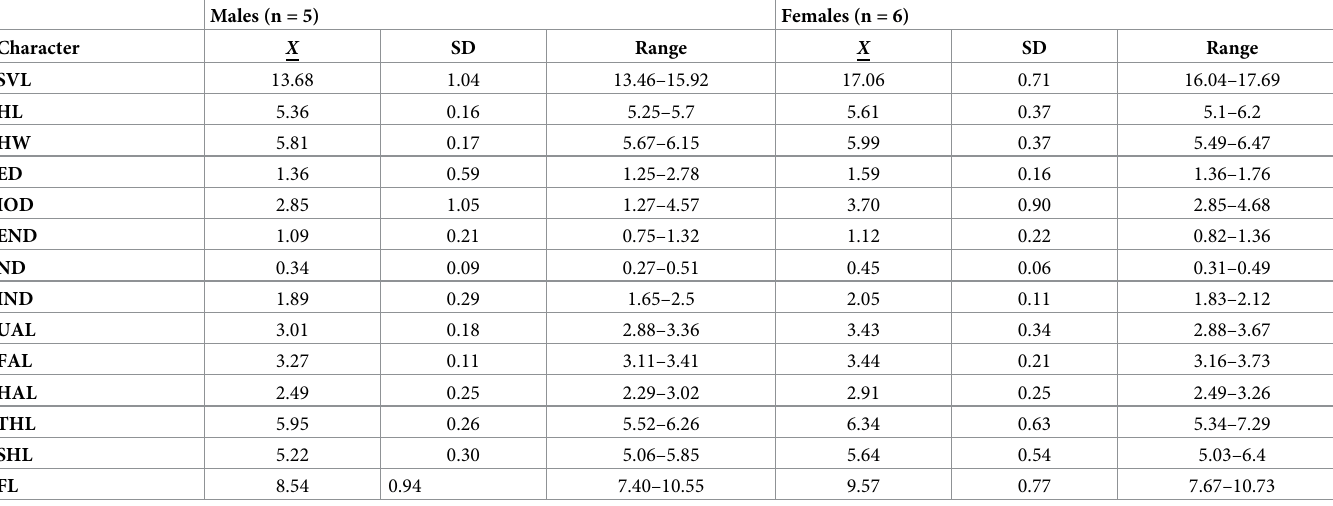
Table 2. Measurements in millimetres of the 11 adults of the type series of Brachycephalus rotenbergae sp. nov. X , mean; SD, standard deviation. Males (n = 5) Females (n =